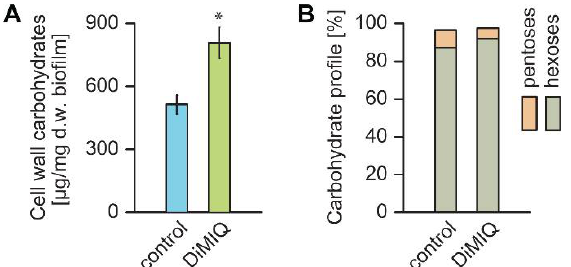
Figure 3. DiMIQ-induced alterations in cell walls of C. albicans biofilms. ( A ) Exposure of biofilm fungal cells to DiMIQ resulted in increased cell wall production. Mean ± SD values shown. * p < 0.01. ( B ) DiMIQ-treatment affected percentage carbohydrate profiles of fungal cell walls by increasing the content of hexoses and simultaneously reducing pentoses. Mean values are shown.